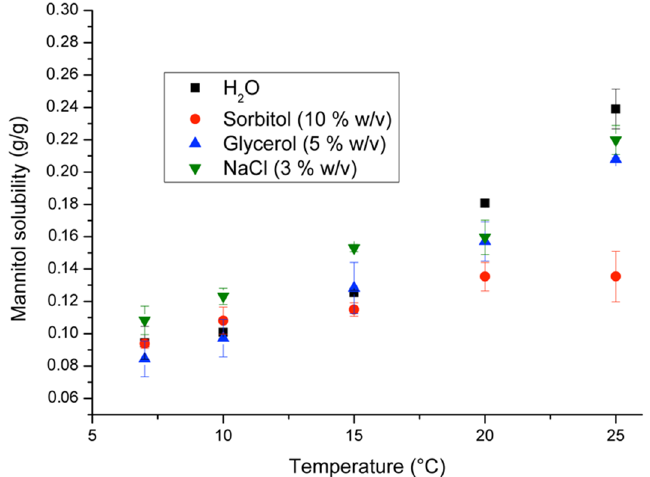
Figure 5. Solubility curve for mannitol in deionised water, glycerol (5% w / v ), sorbitol (10% w / v ) and NaCl (3% w / v ) from 7 to 25 °C.